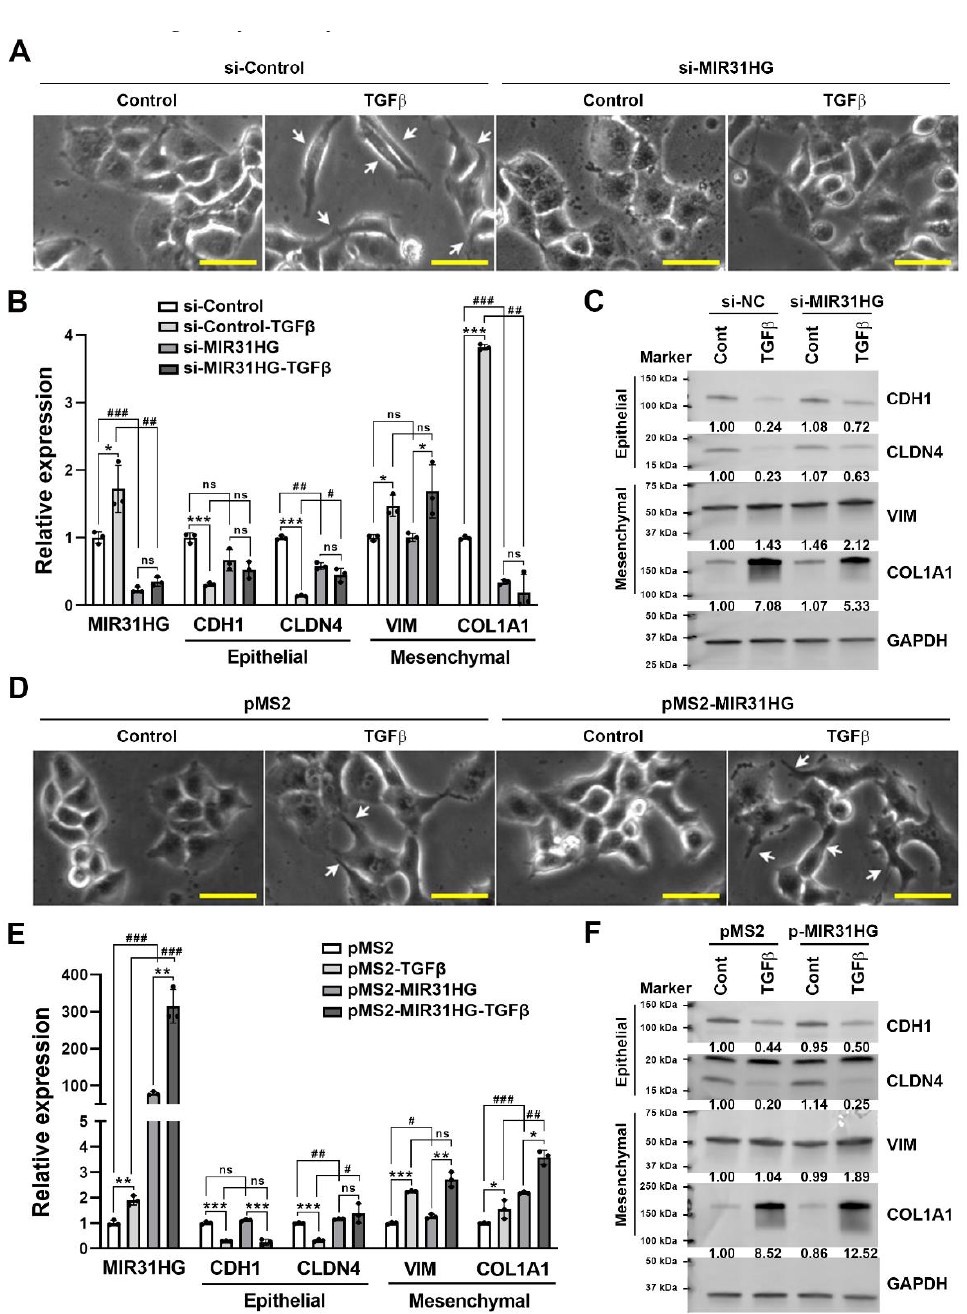
Figure 4. Knockdown of MIR31HG reversed transforming growth factor β ( TGFβ ) -induced epithelial-to-mesenchymal transition (EMT) phenotypes: ( A ) PANC-1 cells were transfected with MIR31HG or control siRNA for 24 h and then exposed to 5 ng/mL TGFβ for another 48 h. The cell morphology was observed under bright-field microscopy. The arrows indicate cells with spindle-shaped, fibroblast-like morphology. S cale bar, 25 μm ; ( B ) PANC-1 cells were transfected with MIR31HG or control siRNA for 24 h and then exposed to 5 ng/mL TGFβ for another 24 h. Total RNAs were examined by a real-time qPCR for MIR31HG and EMT marker expressions. Results are shown as the mean ± standard deviation (SD). * p <0.05 and *** p <0.001 or # p <0.05, ## p <0.01, and ### p <0.001 indicate statistical significance between groups. ns, no statistical significance between indi- cated groups; (C) PANC-1 cells were transfected with MIR31HG or control siRNA for 24 h and then exposed to 5 ng/mL TGFβ for another 48 h. Total protein lysates were examined by Western